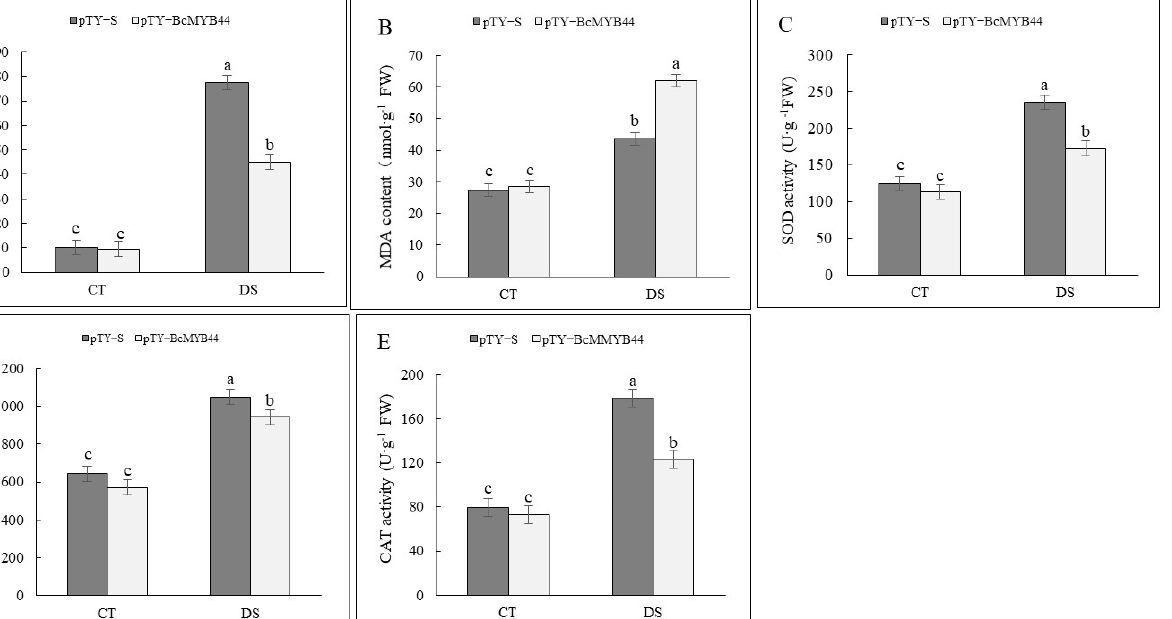
Figure 9. Physiological indexes of non-heading Chinese cabbage under drought stress. They were in order of relative water content ( A ), relative conductivity ( B ), total anthocyanin content ( C ), chlo- rophyll content ( D ), photosynthetic rate ( E ), transpiration rate ( F ), stomatal conductance ( G ) and stomatal aperture ( H ).